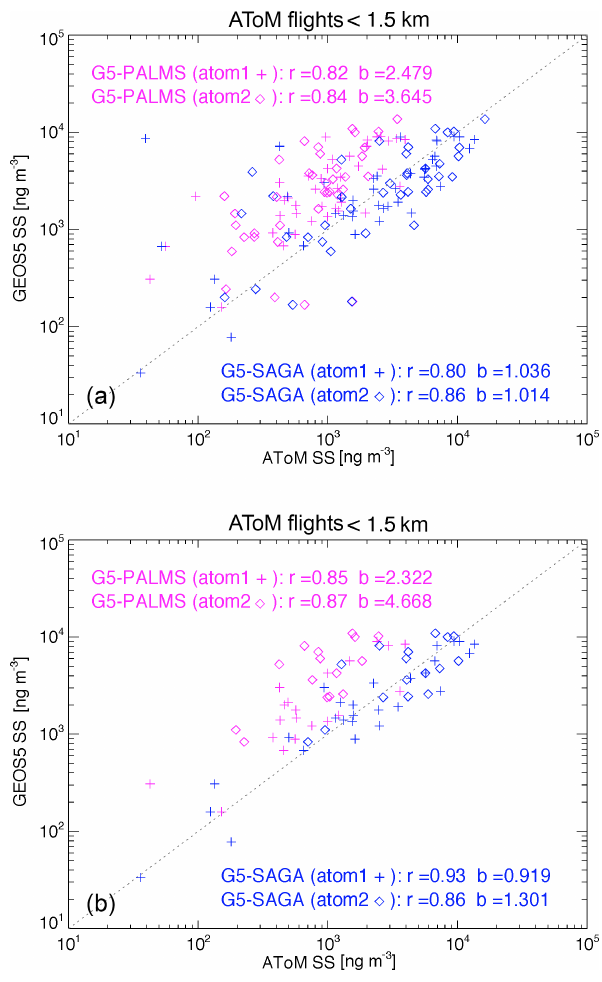
Figure 2. (a) Scatter plot of sea salt between GEOS and PALMS (magenta) and between GEOS and SAGA (blue) in ATom1 (sym- bol + ) and ATom2 (symbol (cid:5) ) for all flight measurements within 1.5km atmospheric thickness above ocean surface. The SAGA sam- ples are filtered out when dust signal is significant. The GEOS sea salt shown here are cut at 3µm in dry diameter. Both GEOS and PALMS data are then sampled using SAGA measurement time fre- quency. The statistical parameter r is the correlation coefficient and b is the ratio of SS(GEOS) to SS(ATom). (b) Similar to (a) with the samples contaminated by clouds further excluded using CAPS cloud